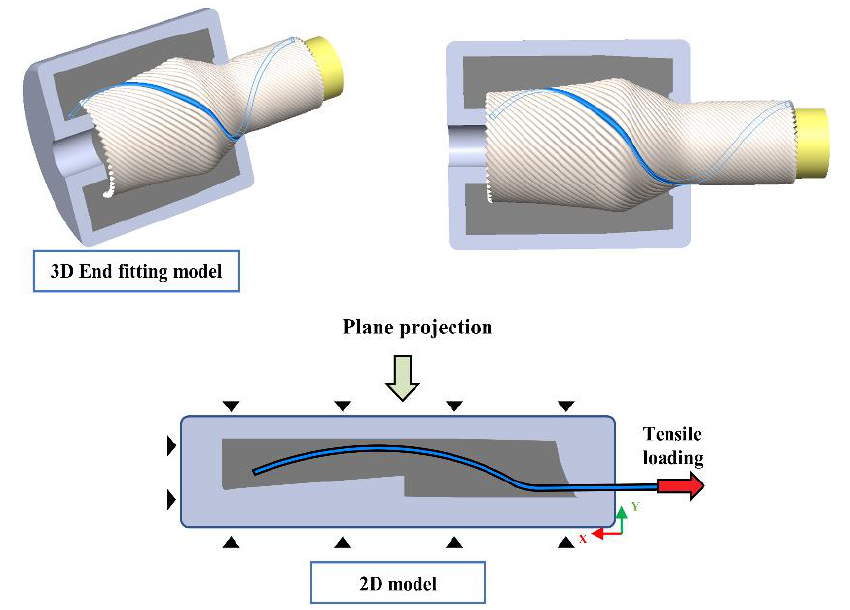
Figure 4. End fitting model and simplification.